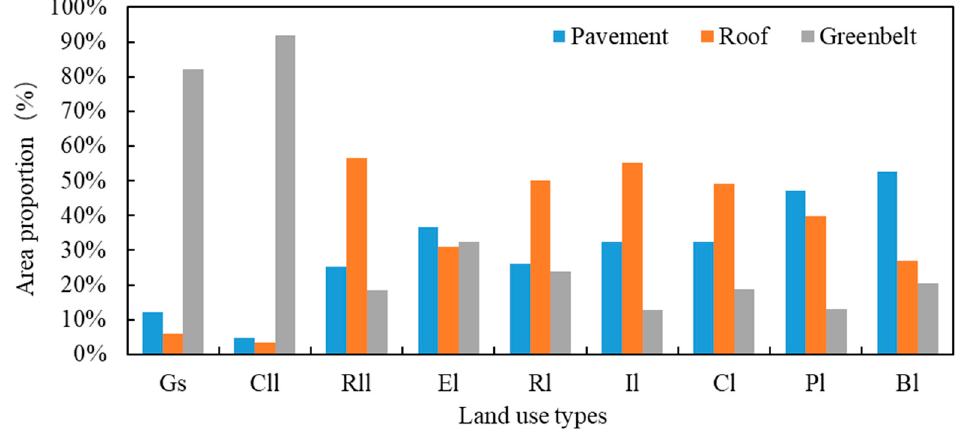
Figure 3. Area proportions of land surface areas of different land use types. The abbreviations on